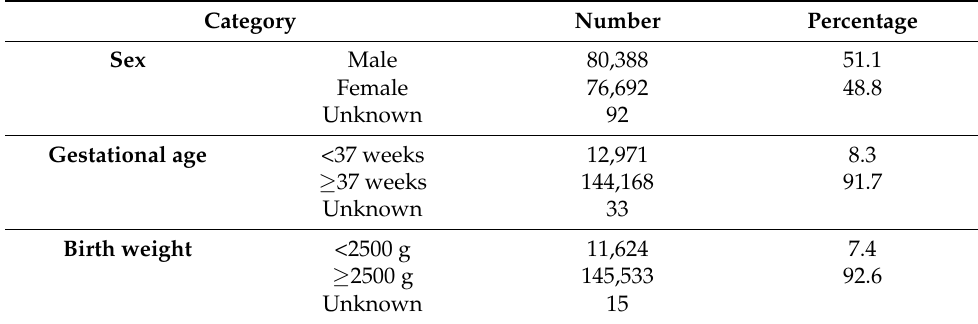
Table 1. Demographic information of newborns screened for severe combined immunodeficiency (SCID). Category Number Percentage